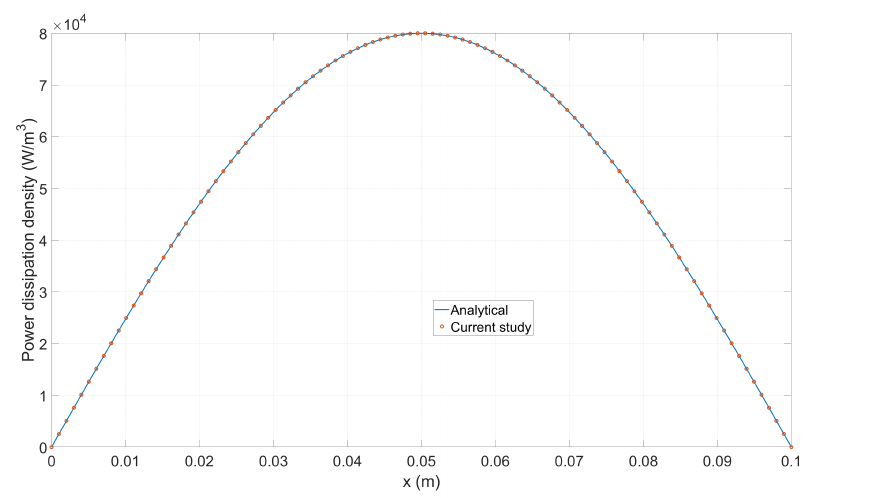
Figure 6. Heat generation in axial direction calculated by FEM and analytical solution.